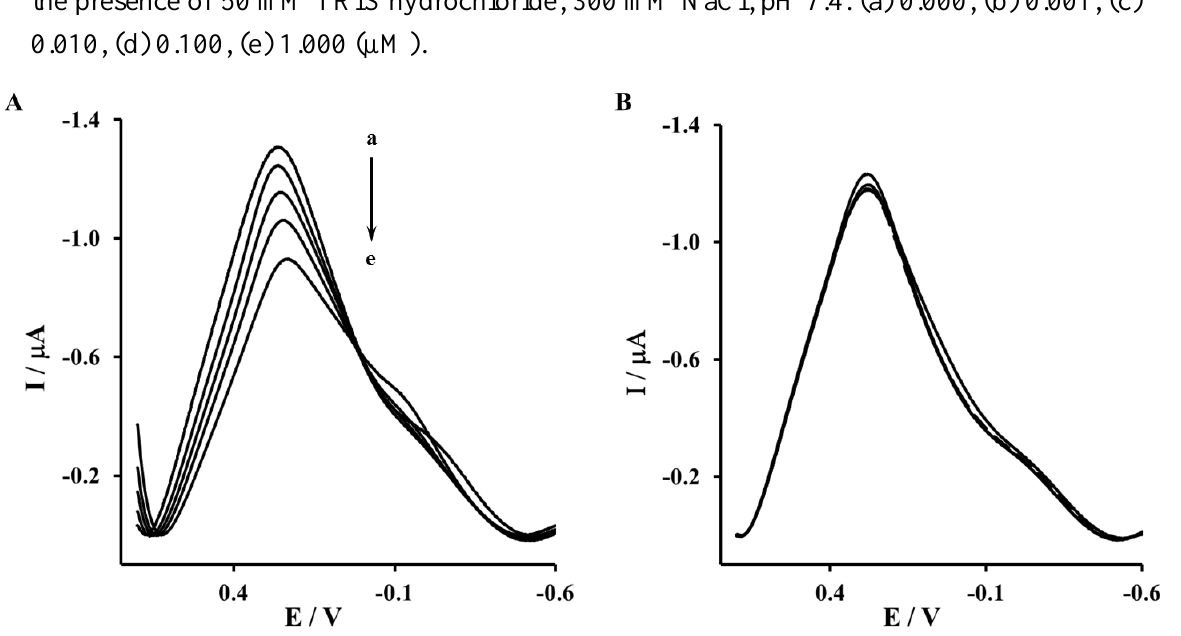
–RAGE V natural 6 –RAGE V mutated domain towards Aβ in 6 16–23’